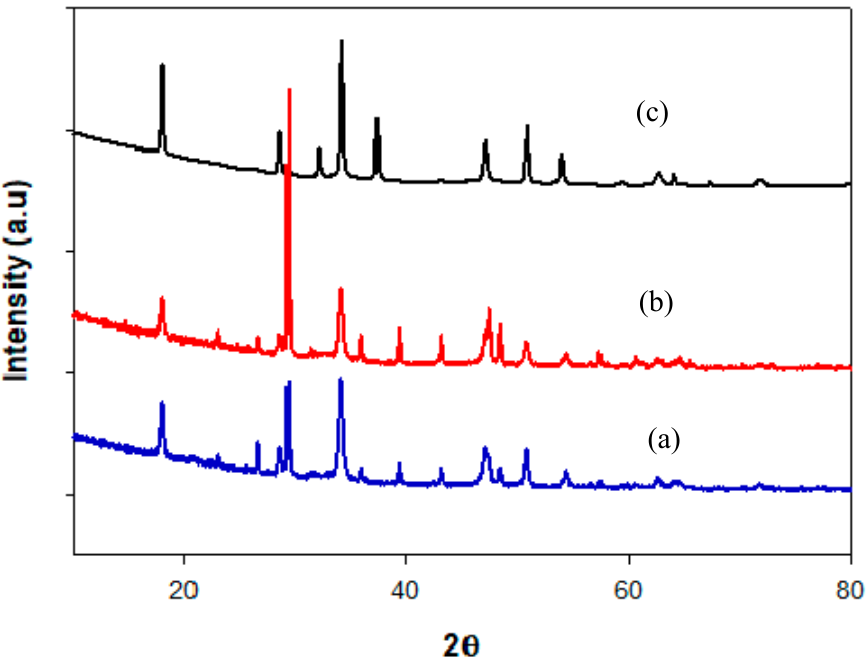
Figure 3. XRD di ff ractogram of CaO / PMFA calcinated at 900 ◦ C for 3 h at di ff erent dehydration times Figure 3. XRD diffractogram of CaO/PMFA calcinated at 900 °C for 3 h at different dehydration times of ( a ) 2, ( b ) 3, and ( c ) 4 of ( a ) 2, ( b ) 3, and ( c ) 4 h.